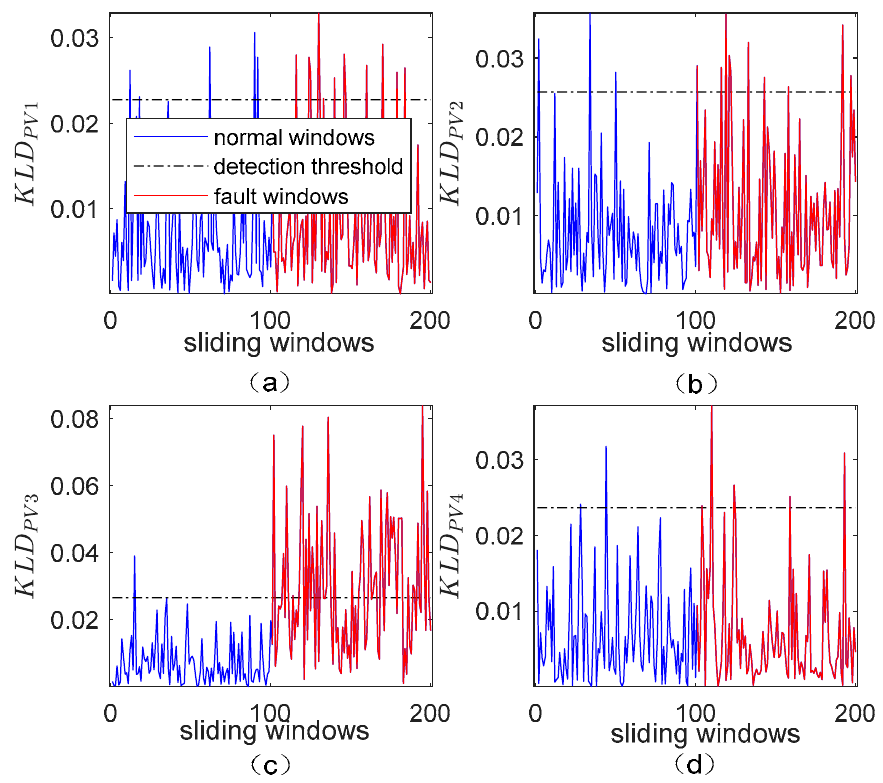
Figure 5. The detection result of the proposed method for the incipient fault f 1 .